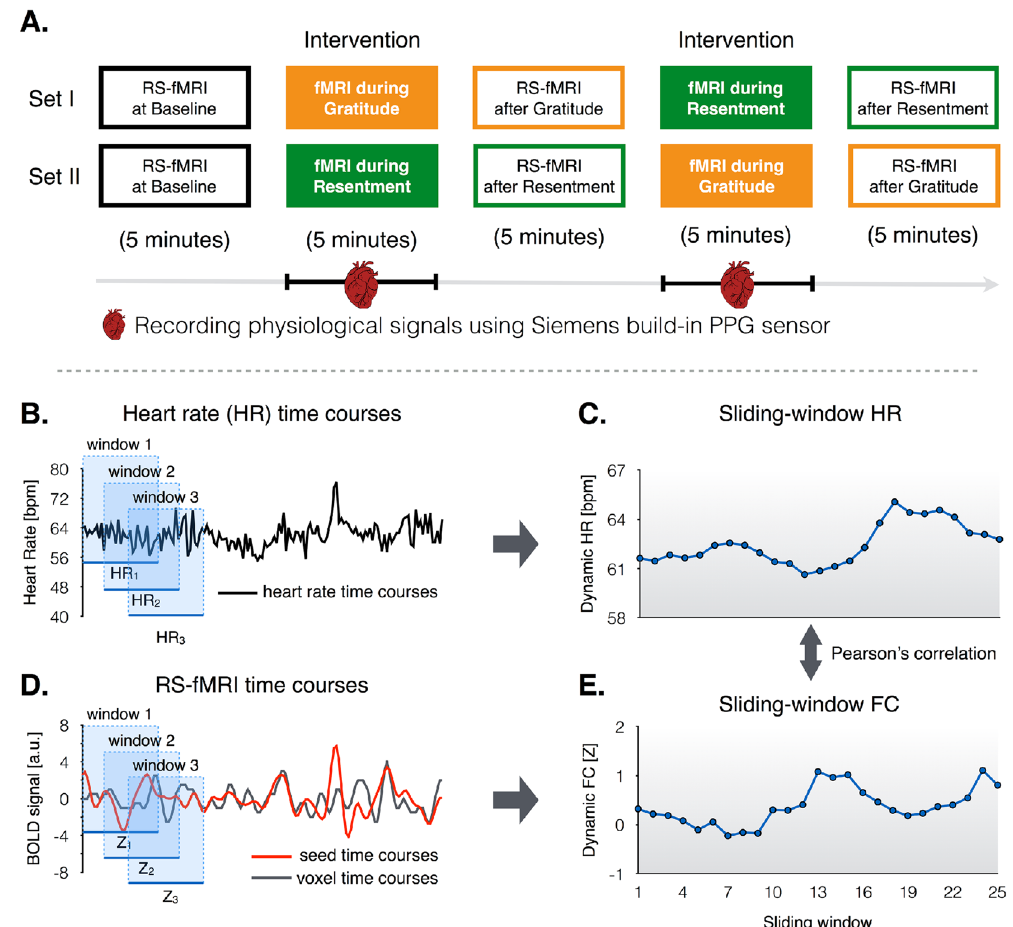
Figure 5. Experimental procedure ( A ). The order of experiments (set I and II) were counter balanced across participants. Illustration for how to evaluate the temporal synchronization between dynamic functional connectivity and heart rate (HR) during the interventions ( B – E ). Raw time courses and illustration of the sliding-windows for HR ( B ) and fMRI time series ( D ). Strategies to compute the temporal correlation between dynamic HR ( C ) and dynamic FC ( E ). Abbreviations: RS-fMRI, resting-state functional MRI; PPG,